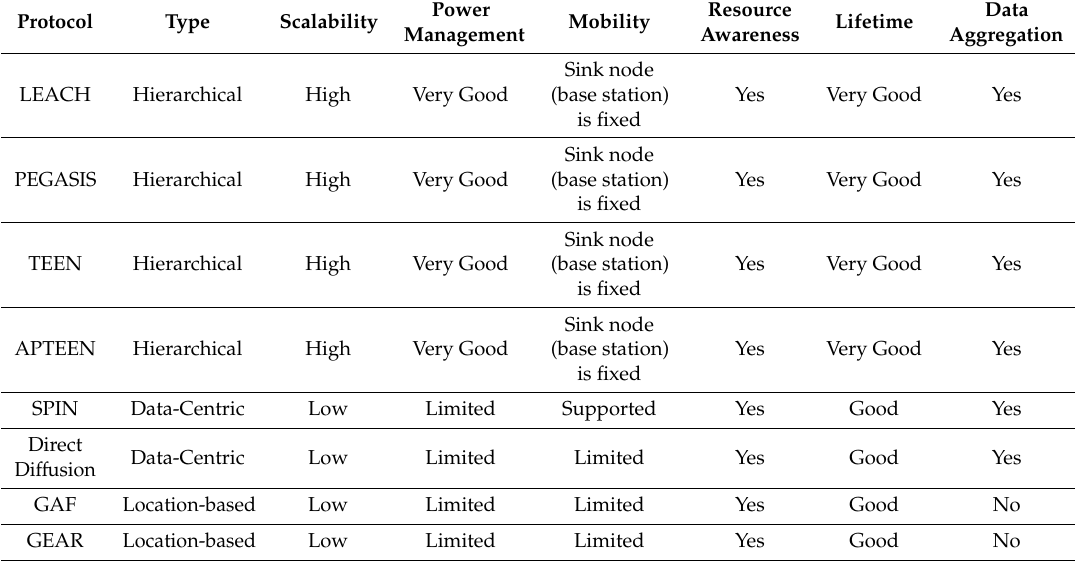
Table 7. Comparison of some key characteristics of various routing protocols for sensor